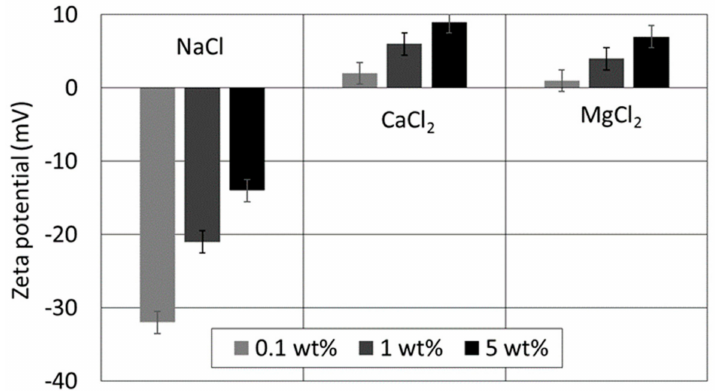
Figure 2. Zeta potential of brine/kaolinite with various ion types and